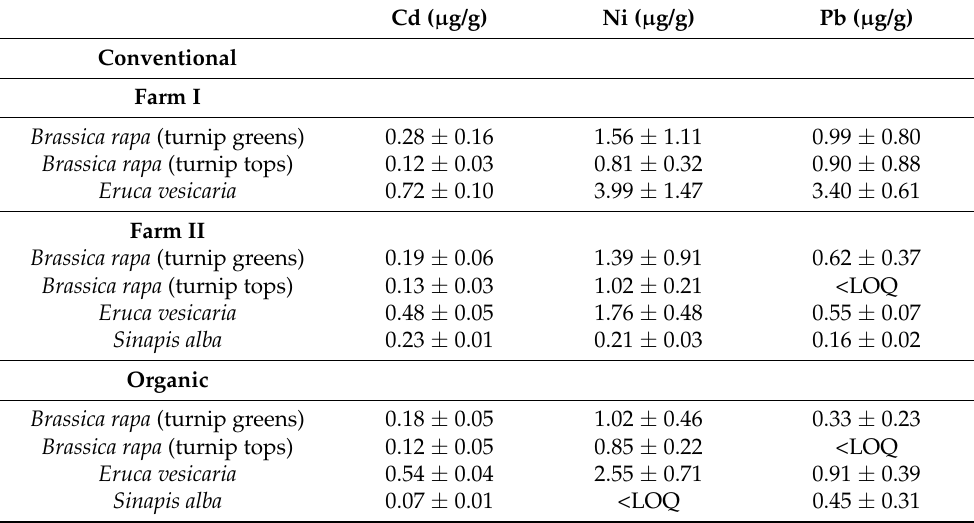
Table 4. Total heavy metals concentration (dry matter) in Brassicaceae species analyzed (mean ± standard